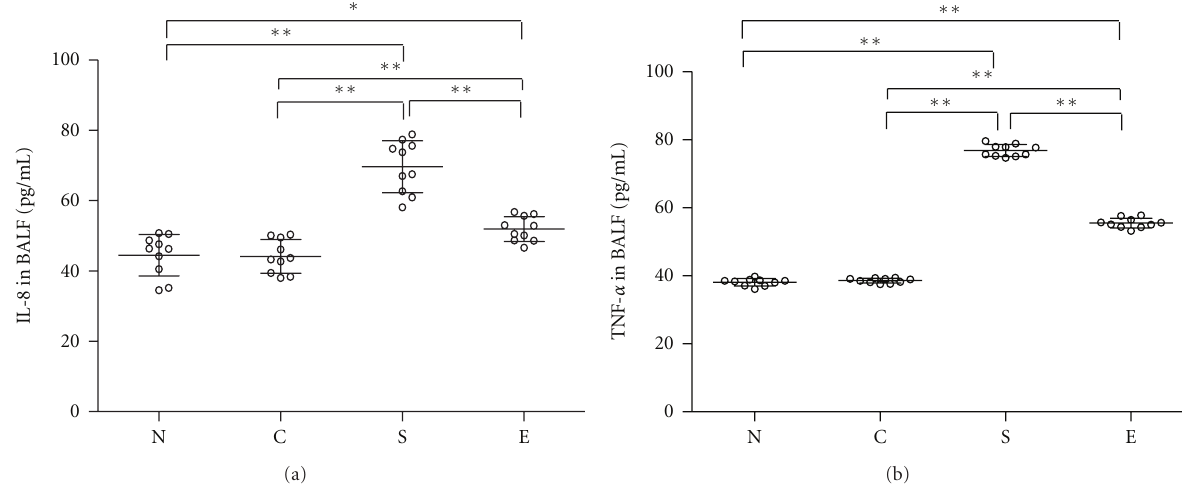
Figure 3: Treatment with erythromycin decreases the levels of TNF- α , IL-8 in the lungs of rats. The levels of TNF- α and IL-8 in BALF of individual rats were analyzed by ELISA. Data shown are mean values of individual samples from three separate experiments and mean values for each group of rats ( n = 10). Group N: rats exposed to regular air without any special treatment; Group C: rats exposed to regular air and were treated with erythromycin; Group S: rats exposed to smoking air and were treated with saline; and Group E: rats exposed to smoking air and were treated with erythromycin daily for nine weeks beginning at the forth weeks smoking. ∗ P < 0 . 05, ∗∗ P < 0 .